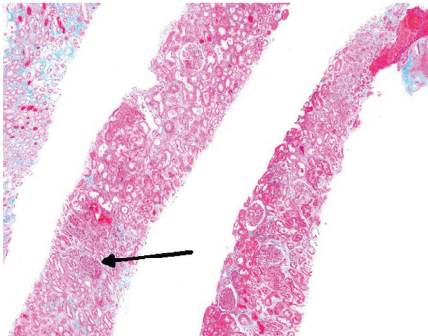
Figure 3: Light microscopy of a renal biopsy with multiple cores of renal tissue, of which approximately 40% is represented by